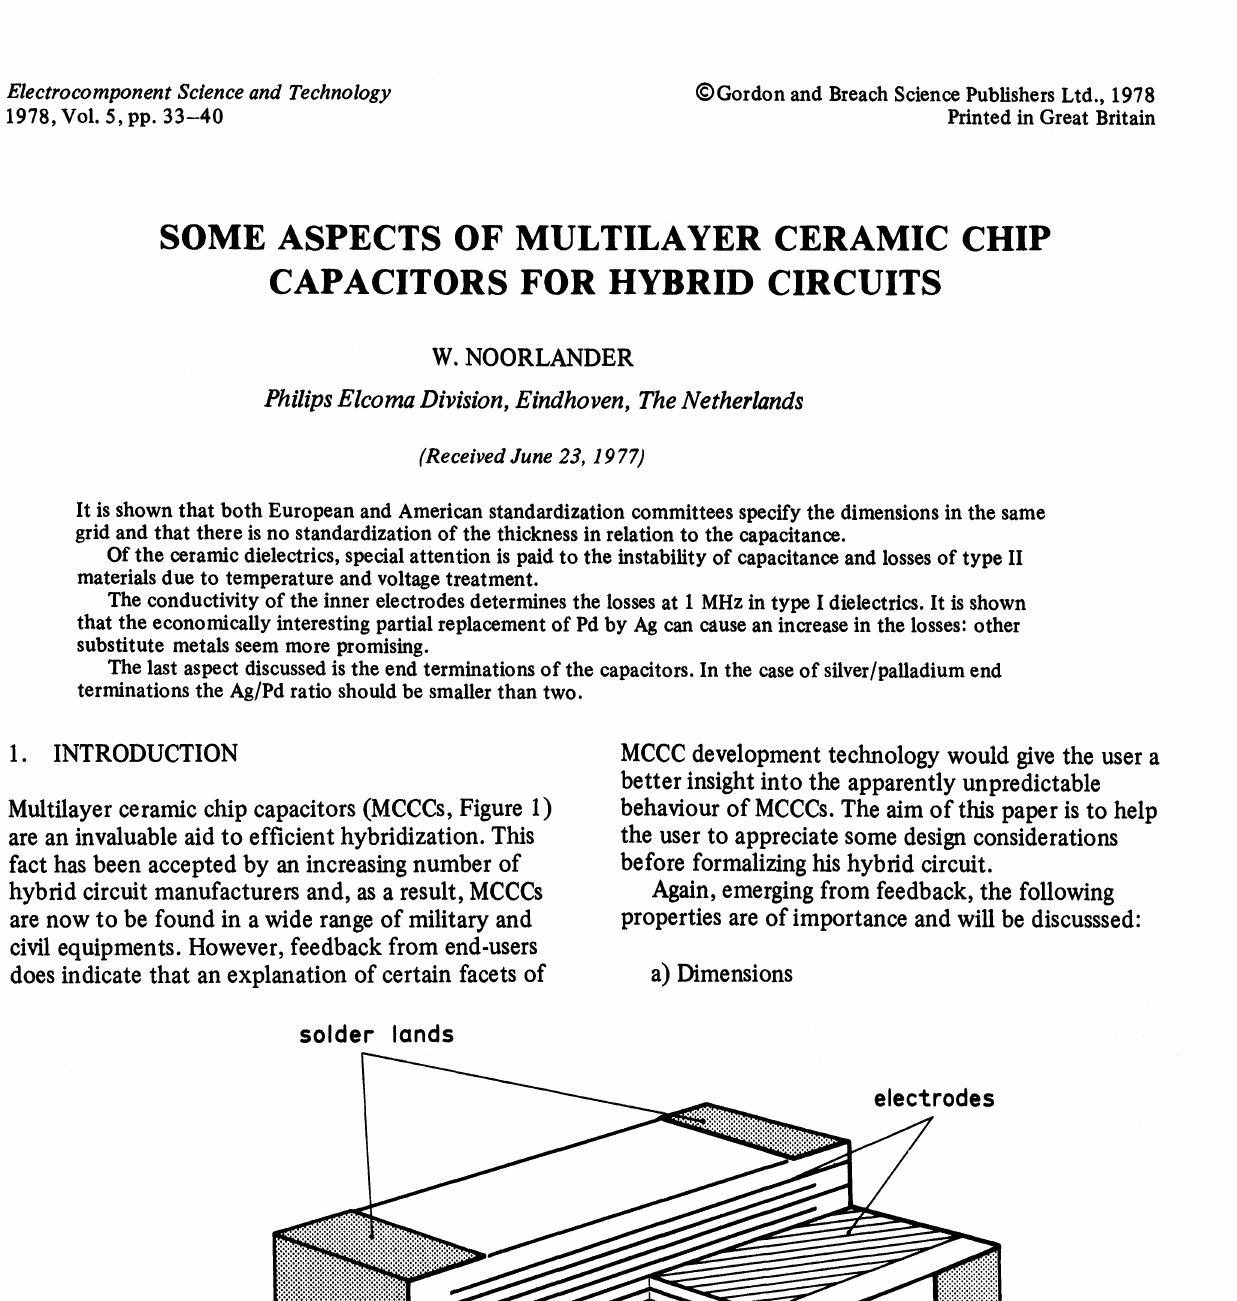
ceramic material 7Z65621 FIGURE 1 MCCCs cutaway